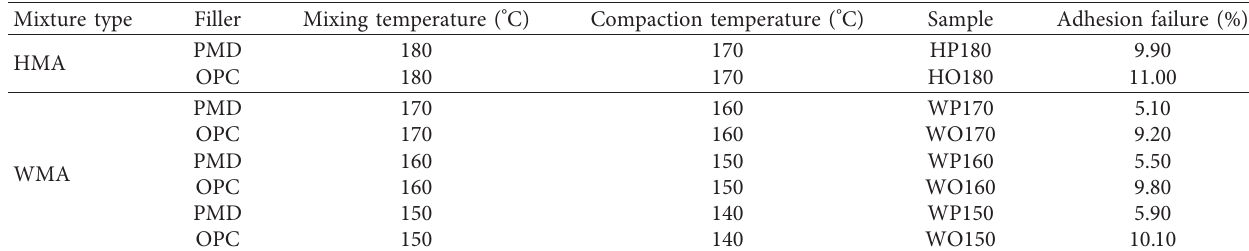
Table 18: Computation for percentage of adhesion failure for 3FT